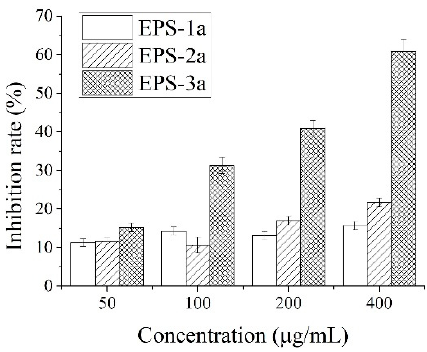
Figure 7. Test of EPS on cell proliferation of human liver cancer HepG2 cell line. The concentrations of EPS-1a, EPS-2a, and EPS-3a were either 50, 100, 200, and 400 μ g/mL.